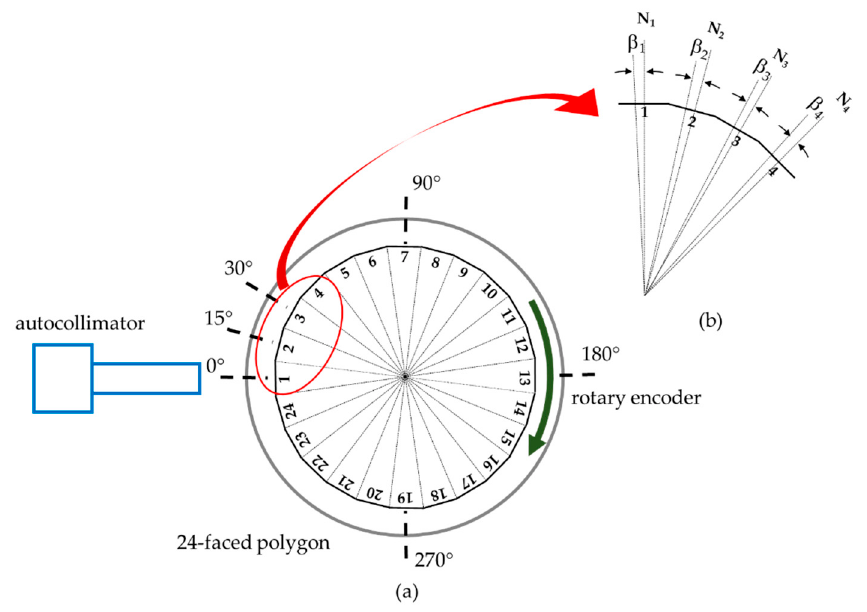
Figure 1. ( a ) Diagram of the 24-faced polygon. ( b ) Enlarged view of the red circle highlighted in ( a ). In the ideal polygon, the measuring faces are the same as the nominal faces. The measuring face (R) and the nominal face (N) are slightly tilted with respect to each other, as indicated in Figure 1b. For the 24-faced polygon, it is assumed that one full circle is divided into 24 nominal faces. The angle interval between two consecutive nominal faces